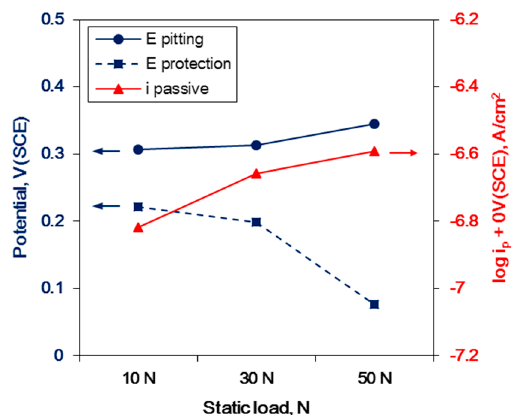
Figure 15. The effect of the static load over the critical UNSM condition on the corrosion factors of Alloy 600.